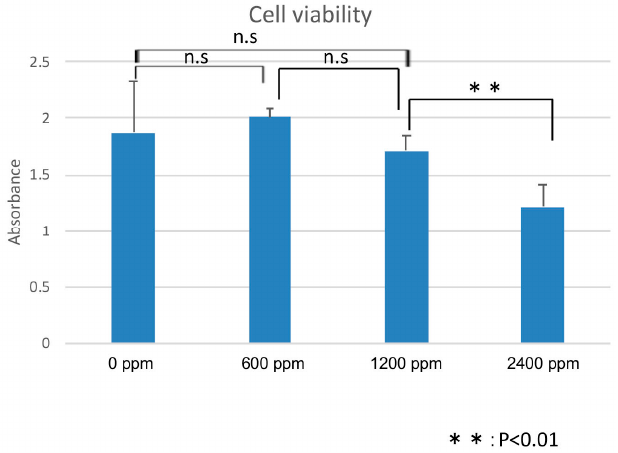
Figure 6. Cell viability assays show that the medium containing 2400 ppm PCSNs resulted in the lowest absorbance. The difference between 2400 ppm PCSNs and the other samples was statistically significant. Thus, a PCSN concentration of 2400 ppm damages SK-BR3 cells. The y-axis represents the absorbance unit (450 nm). n.s., not significant.